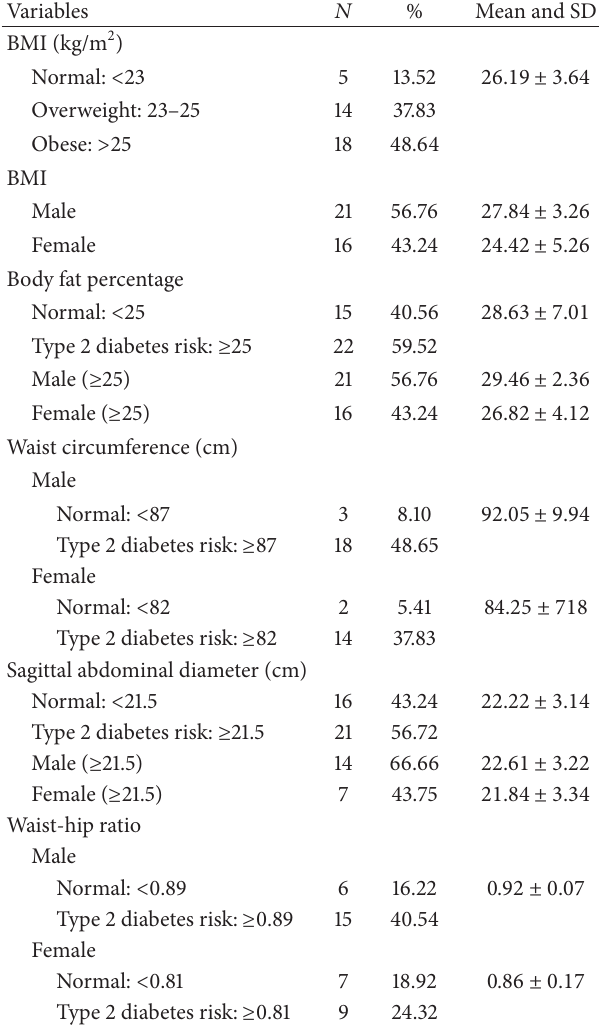
Table 2: Type 2 diabetes risk categories for anthropometric mea- sures and body fat